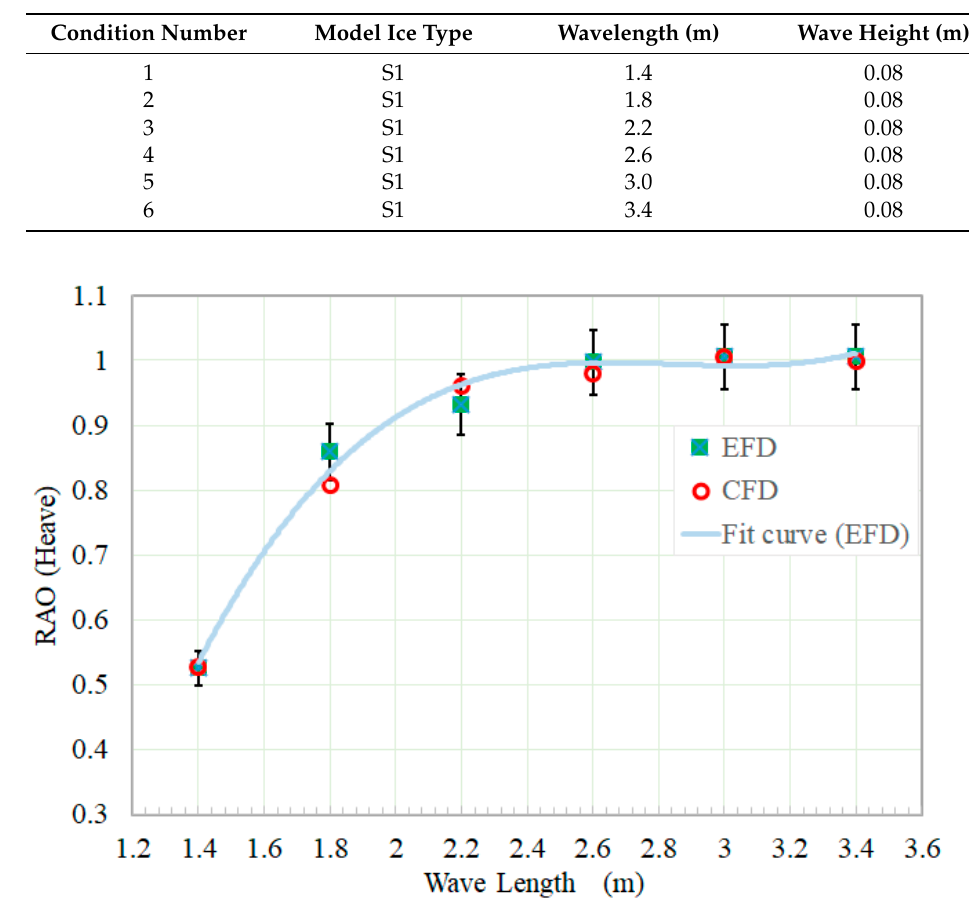
Table 2. Test and simulation conditions.